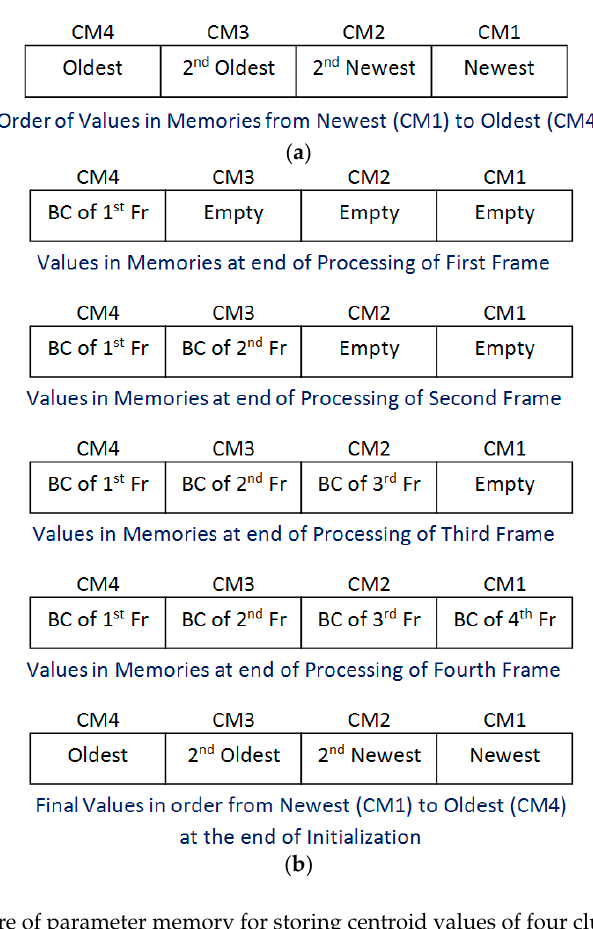
Figure 1. ( a ) Structure of parameter memory for storing centroid values of four clusters; and ( b ) cluster group initialization process.